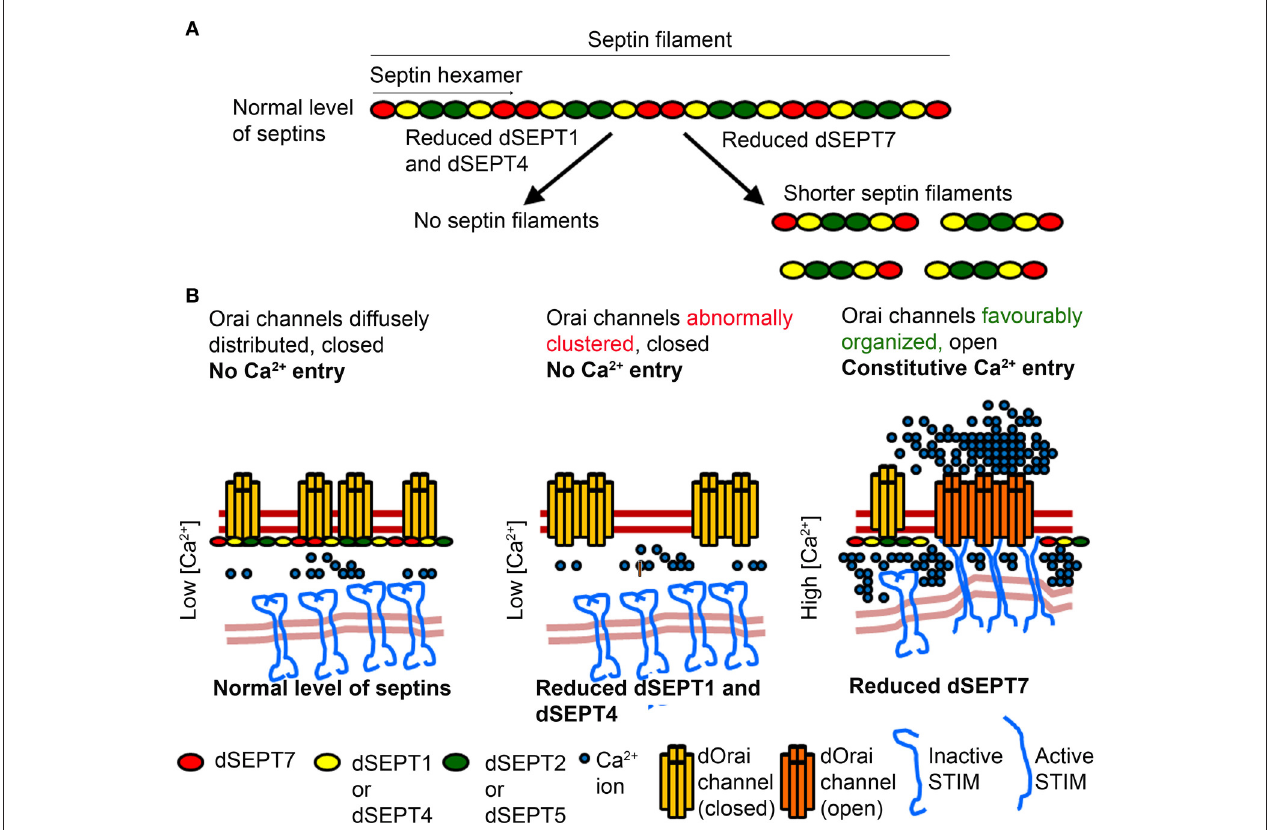
FIGURE 2 | Proposed mechanism by which Septins of the SEPT2 subgroup affect Septin filaments and Orai activation differently from SEPT7 (A) Septin subunits belonging to different subgroups form hexameric complexes that are arranged end to end to form linear non-polar filaments. Reduction of the SEPT2 subgroup, dSEPT1 (or Sep1) and dSEPT4 (or Sep4), results in loss of septin filaments. Reduction of dSEPT7 (or Pnut) results in formation of shorter septin filaments. (B) In resting cells with normal level of Septin subunits, septin filaments help organize lipid domains in the PM, with closed Orai channels. Reduction of the SEPT2 subgroup leads to loss of septin filaments and favor’s a closed conformation of Orai channels. Reduction of dSEPT7 results in shorter septin filaments, which facilitate STIM/Orai coupling and the distribution of Orai in lipid domains, where a constitutively open conformation is favored. Septin filament and Orai architecture depicted in the model are based on genetic and cellular studies but have not been demonstrated